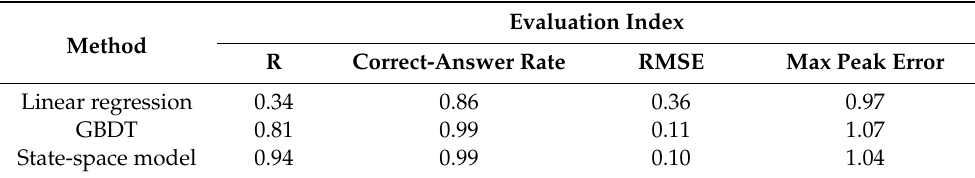
Table 6. Evaluation index of each model (April